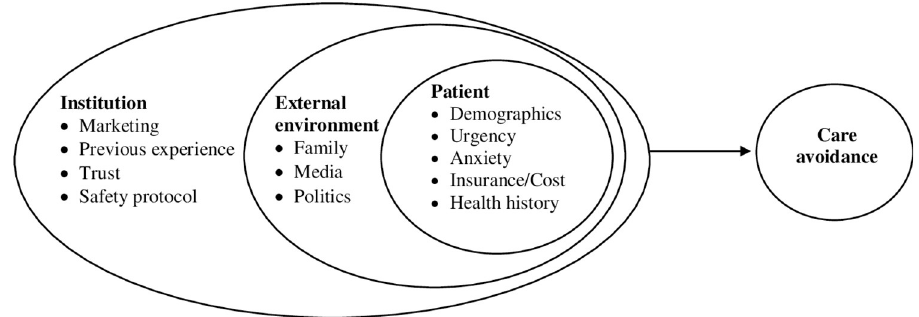
Fig 1. Conceptual model of care